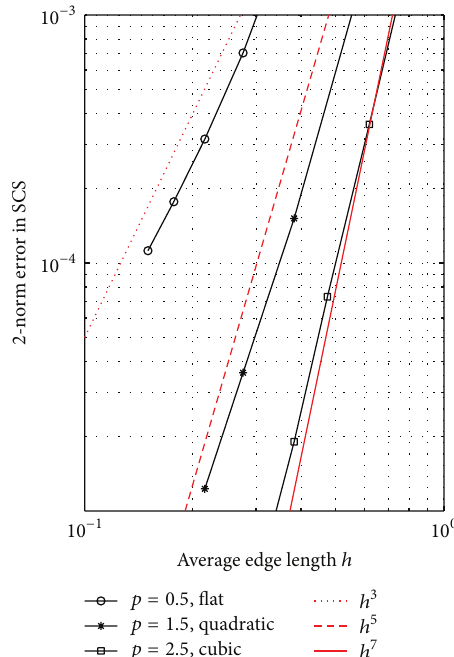
Figure 7: Error in the SCS versus number of unknowns for a torus with ka = 3 and kb = 6, obtained from the MFIE with Galerkin testing. Results are reported for flat-faceted models used in conjunction with 𝑝 = 0.0 basis and test functions, quadratic-curved models used with 𝑝 = 1.0 functions, and cubic-curved models used with 𝑝 = 2.0 functions.